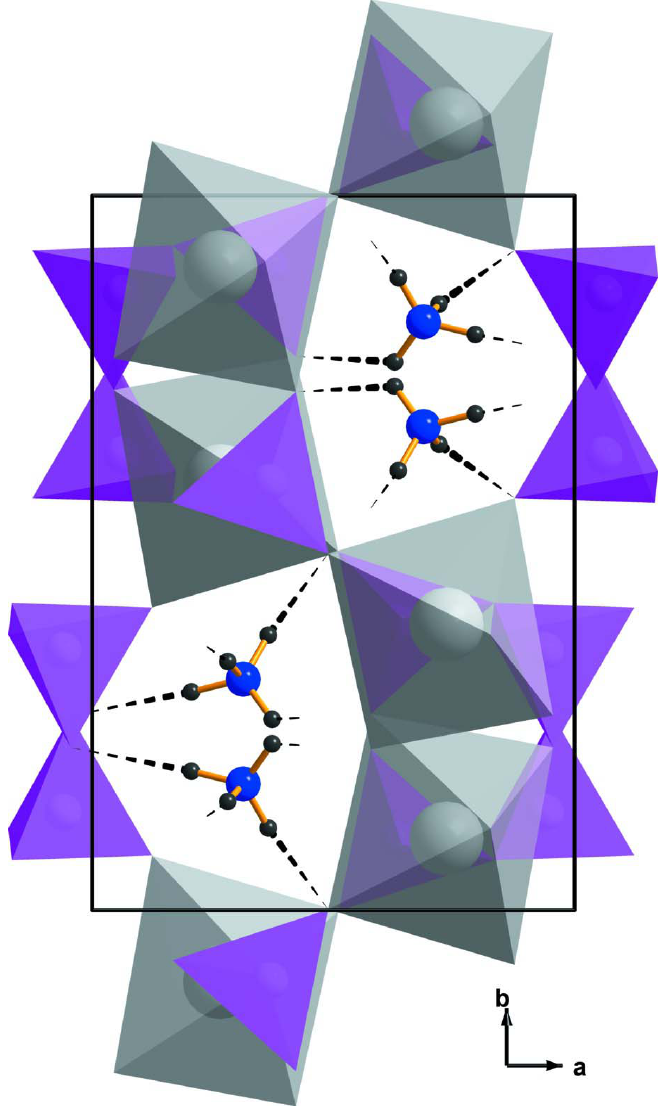
Figure 2 The packing of NH